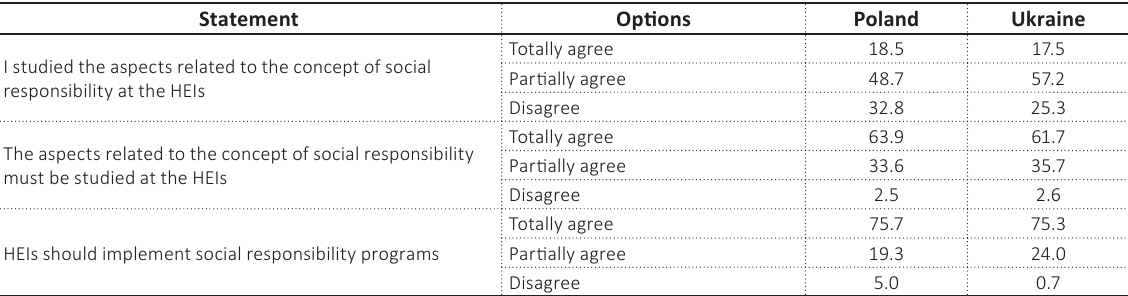
Table 6. Respondents’ answers to the question: Please indicate the most appropriate answer to each statement